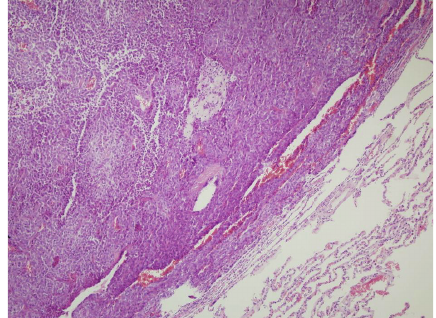
Figure 3: Cellular characteristic of lung parenchyma tumor tissue (H&E ×